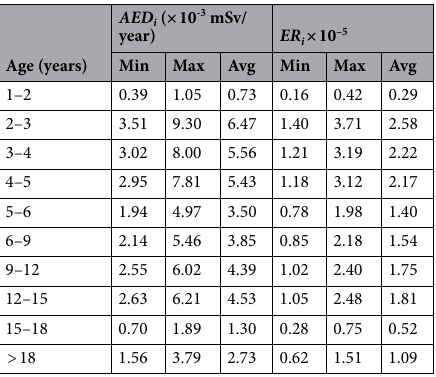
Table 7. Age-dependent annual effective dose ( AED i ) and excess risk ER i induced by the ingestion of drinking water (tap water) for the population around Qinshan NPP from 2012 to